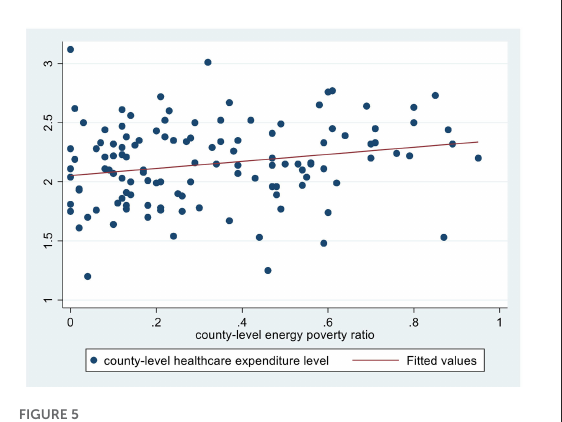
FIGURE3 Energy poverty and respiratory diseases.